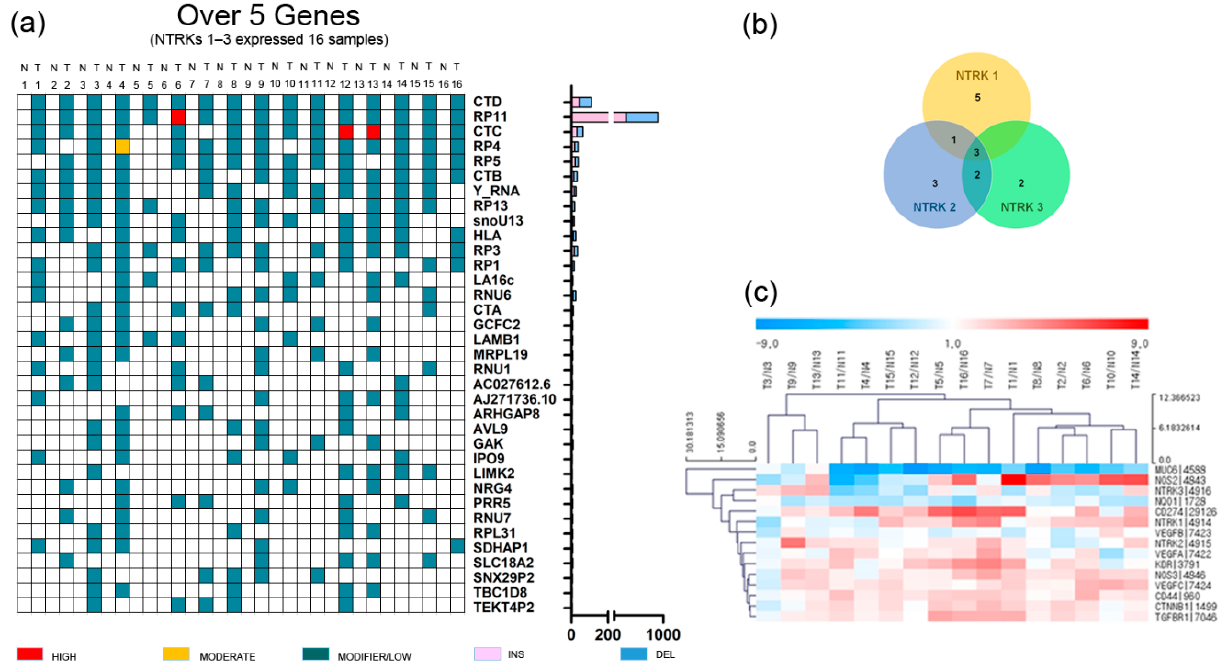
Overexpression: genes differentially expressed in entrectinib-treated cells compared to non-treated cells, ≥ 2.0-fold change.